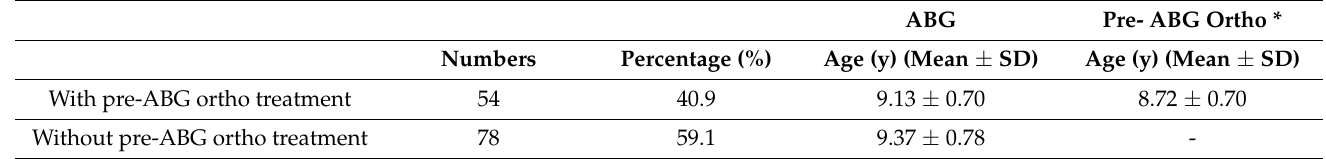
Table 4. Distribution of gender and relationship between gender and the affected side.